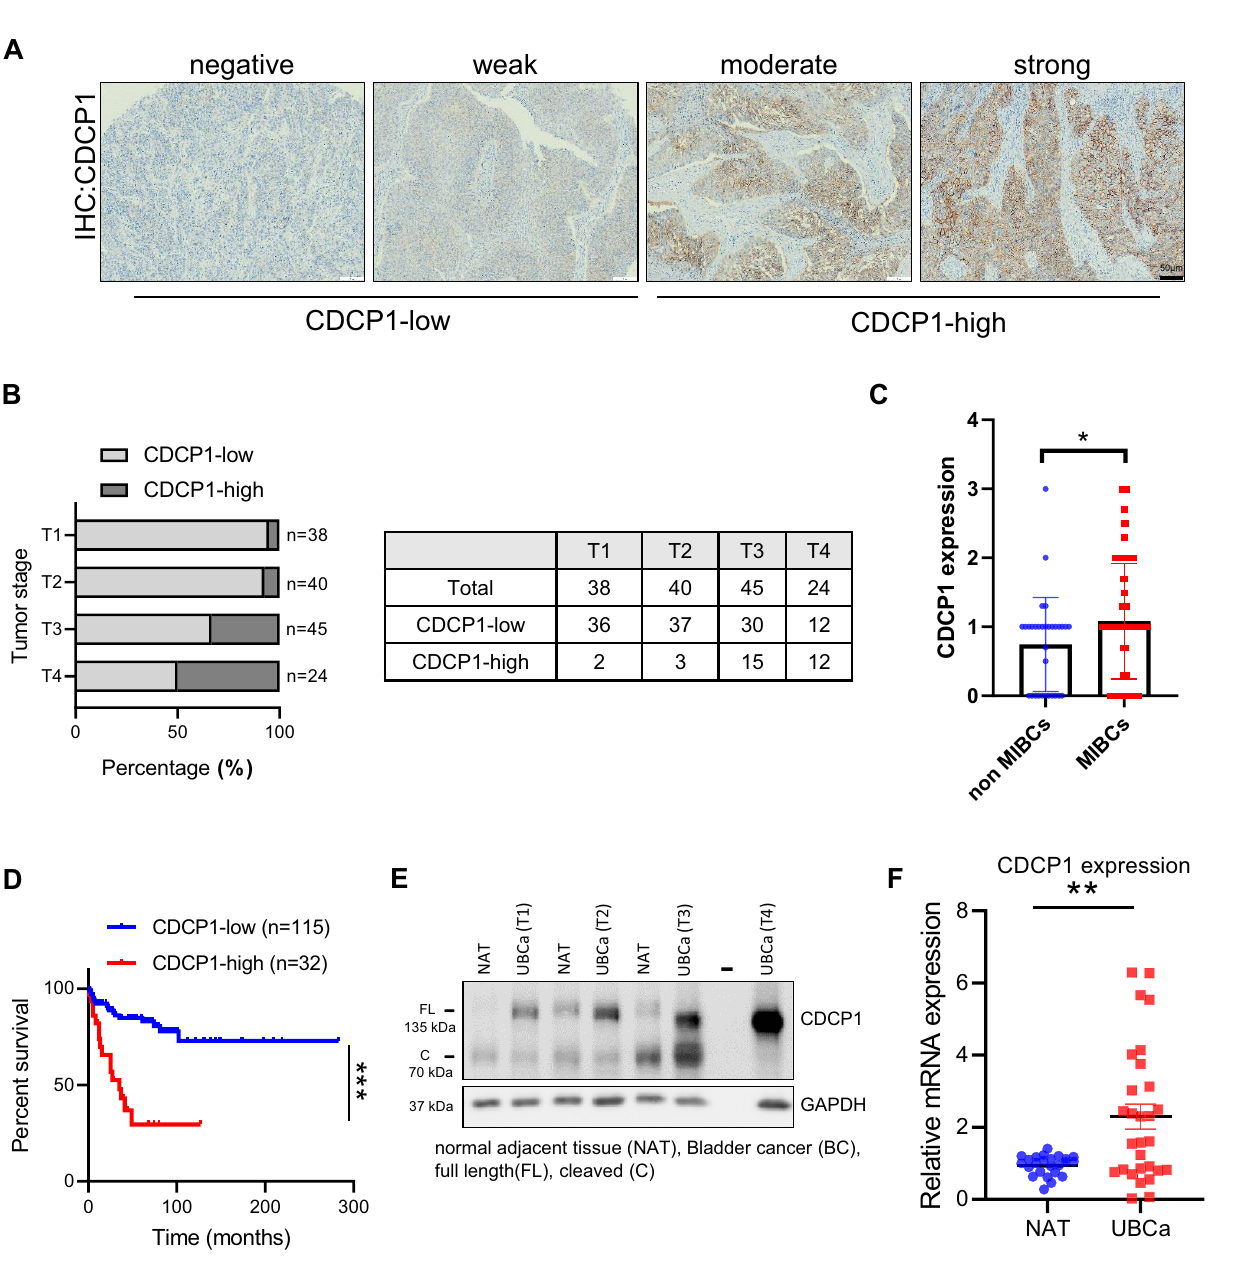
Figure 1. UC exhibits elevated expression of CDCP1, which correlates with shorter overall survival in UC patients. ( A ) Representative images of CDCP1-low and CDCP1-high tumors. ( B ) Percentage of patients expressing low and high CDCP1 levels, divided by the tumor stage (T1, T2, T3, T4). The table indicates the relative number of patients, which express low and high CDCP1 divided per tumor stage. ( C ) Column bar graph comparing the expression of CDCP1 in NMIBC (T1) and MIBC (T2–T4). Error bars indicate SD. *P < 0.05. Statistical test: two-tailed unpaired t test. ( D ) Kaplan–Meier survival analysis of UC patients stratified based on the semi-quantitative expression of CDCP1 (CDCP1-low: negative, weak; CDCP1-high: moderate, strong). ***P < 0.001. Statistical test: log-rank test. ( E ) Western blot analysis of CDCP1 and GAPDH expression on representative tumor samples from patients presenting lesions at different stages (T1, T2, T3 and T4). CDCP1 tumor expression is compared with its expression in the NAT from the same patients. ( F ) Comparison between the expression of CDCP1 in UC samples and NAT at the transcriptional level. Expression was quantified via real-time quantitative PCR, and normalized to GAPDH. Error bars indicate SD. **P < 0.01. Statistical test: two- tailed unpaired t